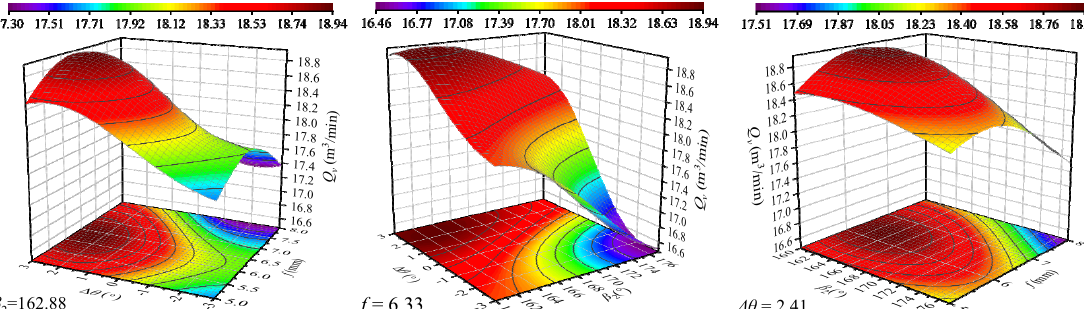
Figure 13. Spatial distribution of RKM under different optimal design parameters.